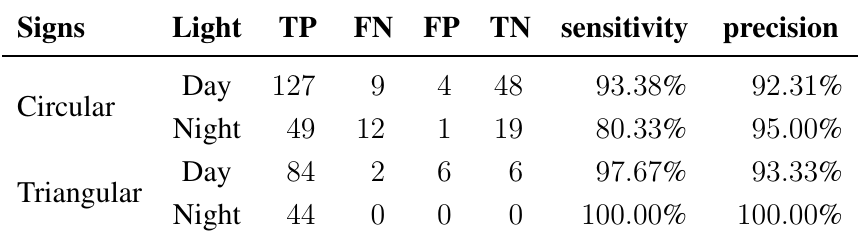
Table 3. Summary of recognition results under different lighting